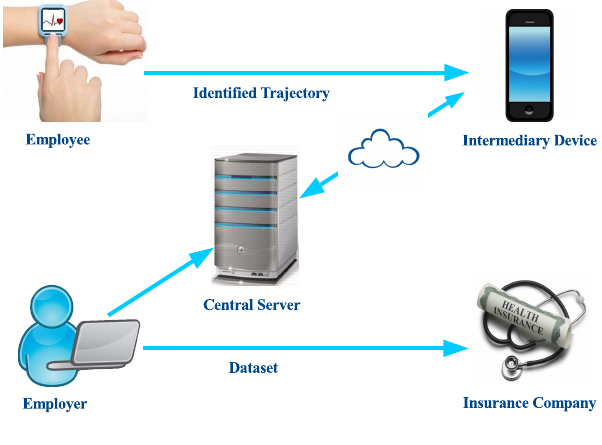
Figure 1. Client-server privacy